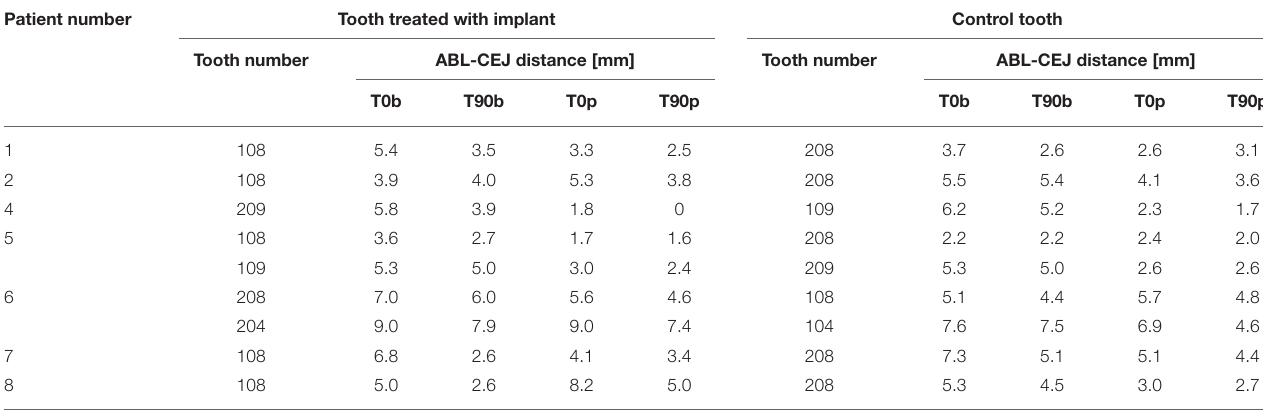
TABLE 2 | Cone-beam computed tomography (CBCT) measurements of the distance between alveolar bone level (ABL) and cementoenamel junction (CEJ) of the treated teeth at the presentation (T0) and 3-month recheck (T90). Patient number Tooth treated with implant Control tooth Tooth